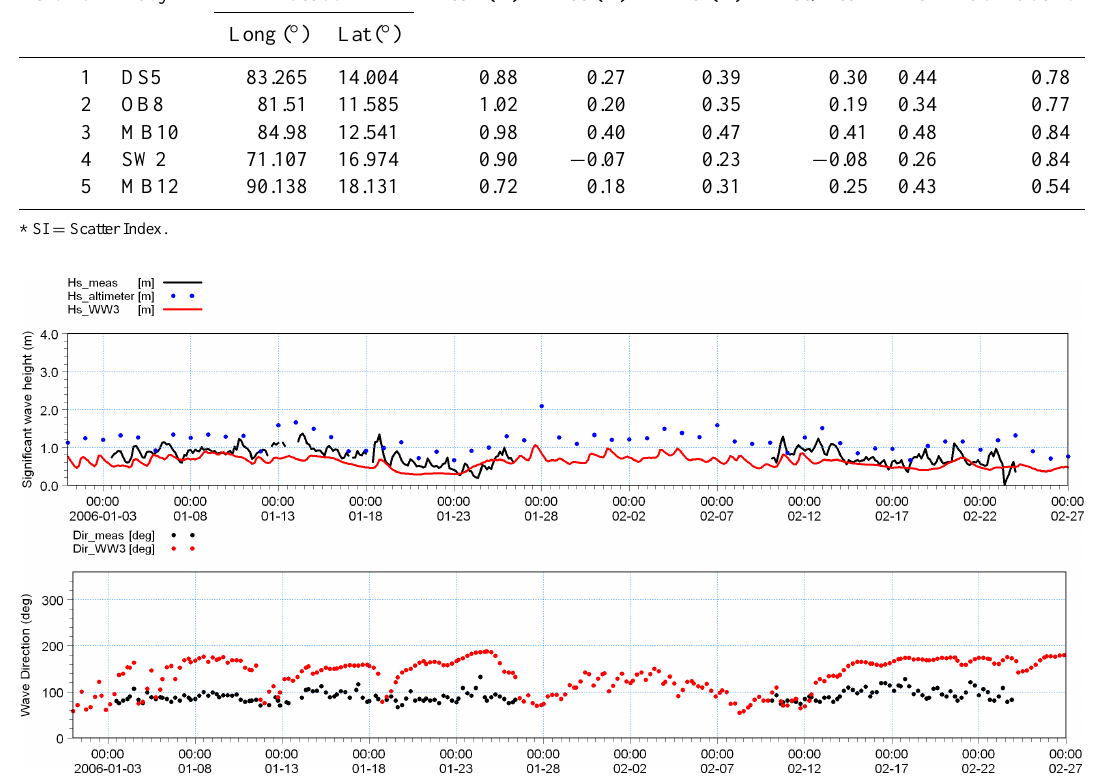
Fig. 4. Comparison between measured (black line) (moored buoy) and modelled (red line) wave heights and wave directions for the period January–February 2006. Altimeter data (blue dots) (shallow water: SW5, off